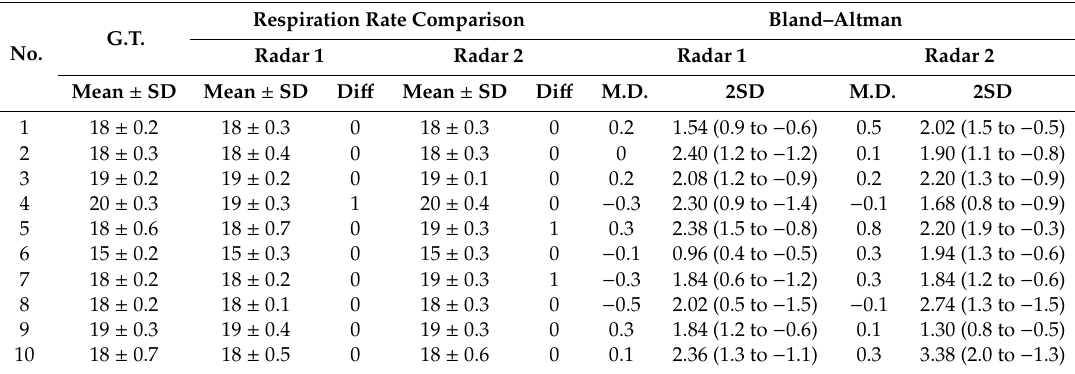
Table 3. Respiration rate results between two radars and the ground truth.